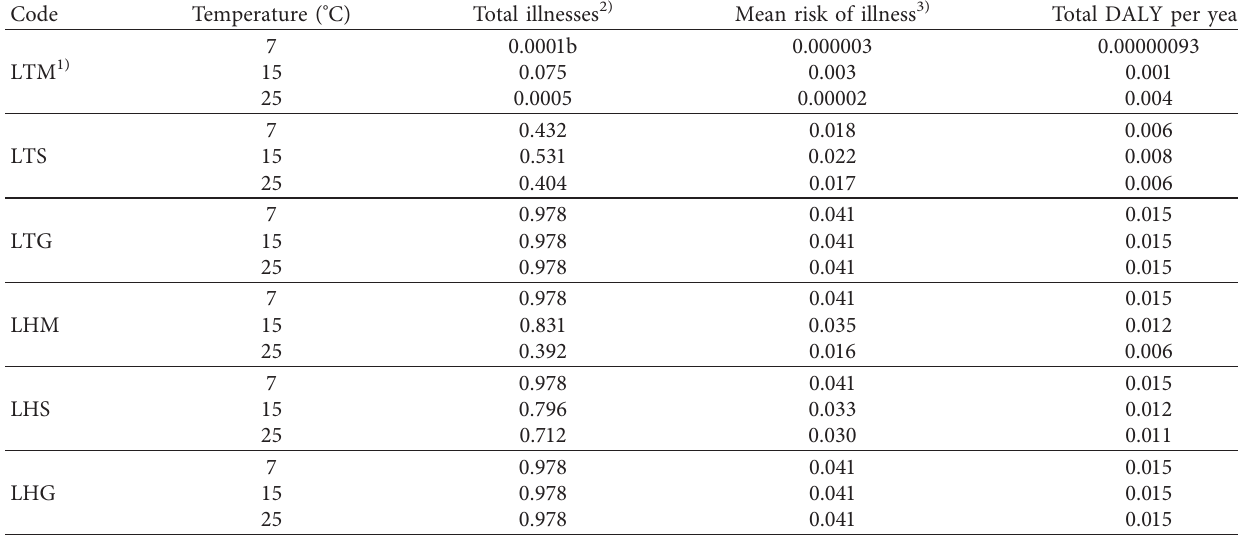
Table 3: FDA-iRISK output: risk ranking of six rice balls stored at 7, 15, and 25 ° C.